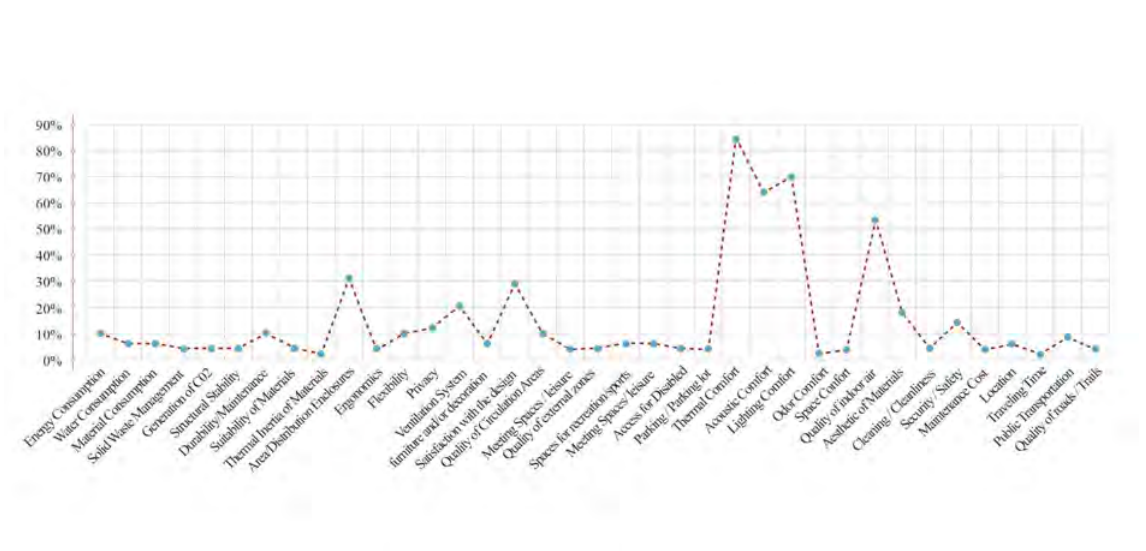
Figure 1. Study factors on buildings in conditions of use. Source: V´asquez-Hern´andez, Alejandro; Restrepo ´Alvarez, M. F. (2017). Evaluation of buildings in real conditions of use: Current Situation (Fig 1). Recovered from: Journal of Building